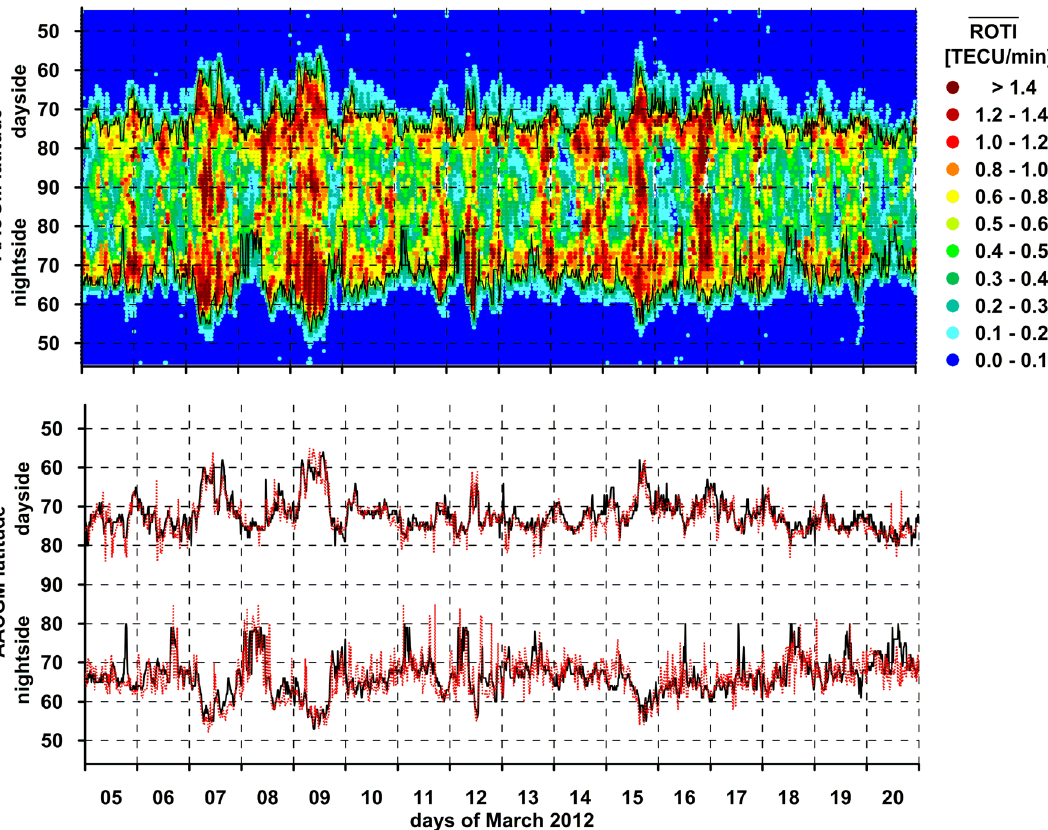
Fig. 12. The average ROTI values observed on both sides of ionosphere for entire analysed period: 5 – 20 March 2012 (top panel). Black lines correspond to outer oval boundary based on the assumption average ROTI > 0.3 TECU/min. The bottom panel presents comparison of equatorward boundaries derived from GNSS (black solid line) and AMPERE datasets (red dotted